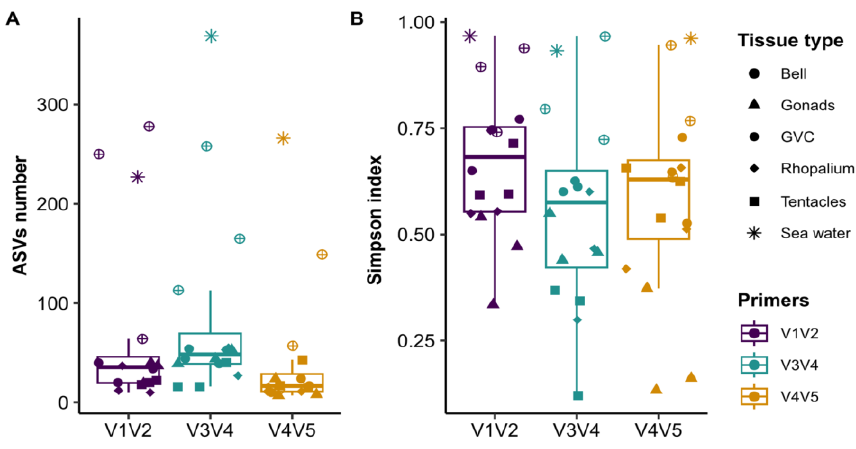
Figure 3. Alpha diversity indexes. ( A ) ASVs numbers. ( B ) Simpson’s Diversity Index. On both alpha diversity indexes, no significant differences were seen between primers (ANOVA, p > 0.05) .